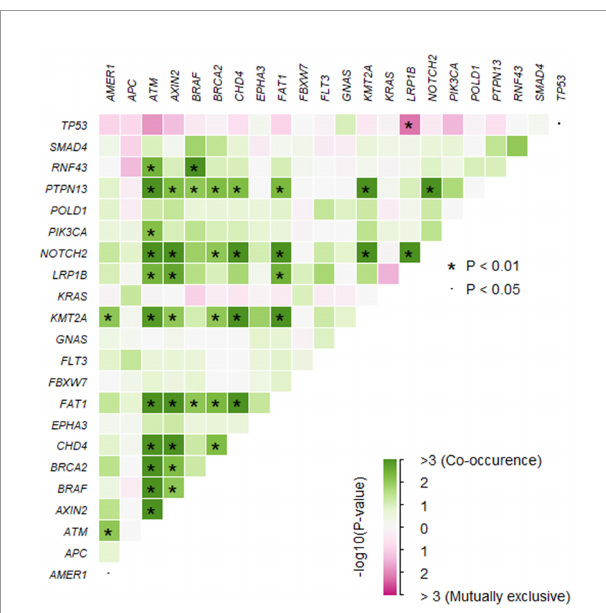
FIGURE 3 | The somatic interactions of the study. Signi fi cant exclusive or co-occurrent variants were analyzed with Fisher ’ s exact